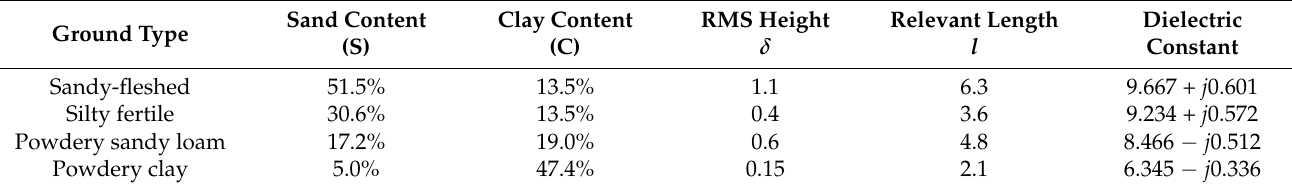
Table 2. Parameters for each of the four ground